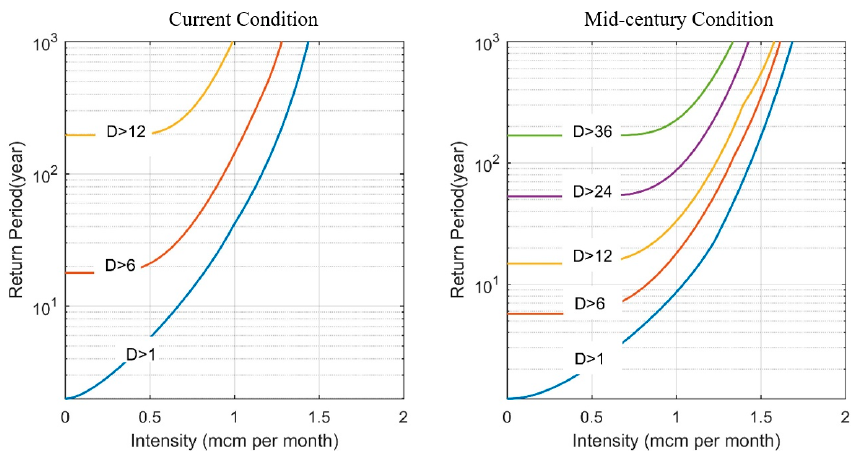
Figure 13. Intensity-duration-frequency curves for current (left-panel) and future conditions (right- panel).